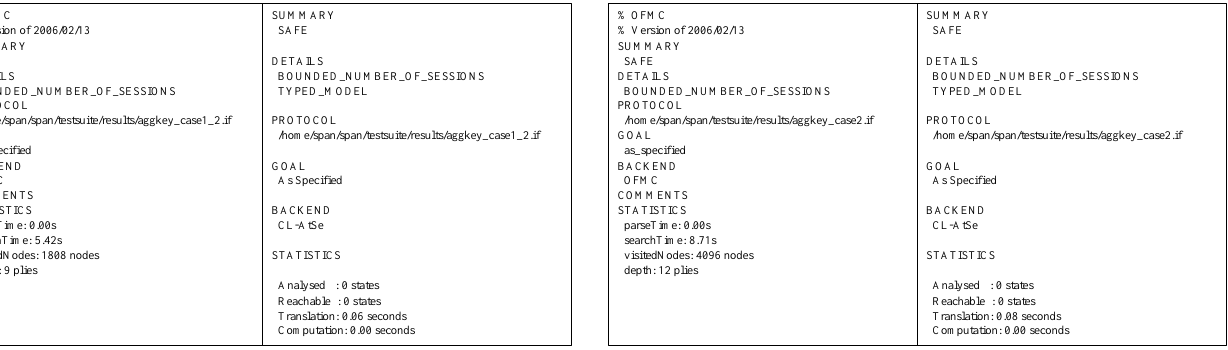
Figure 7. ( left ) Results of data retrieve phase. ( right ) Results of authentication for delegation phase.